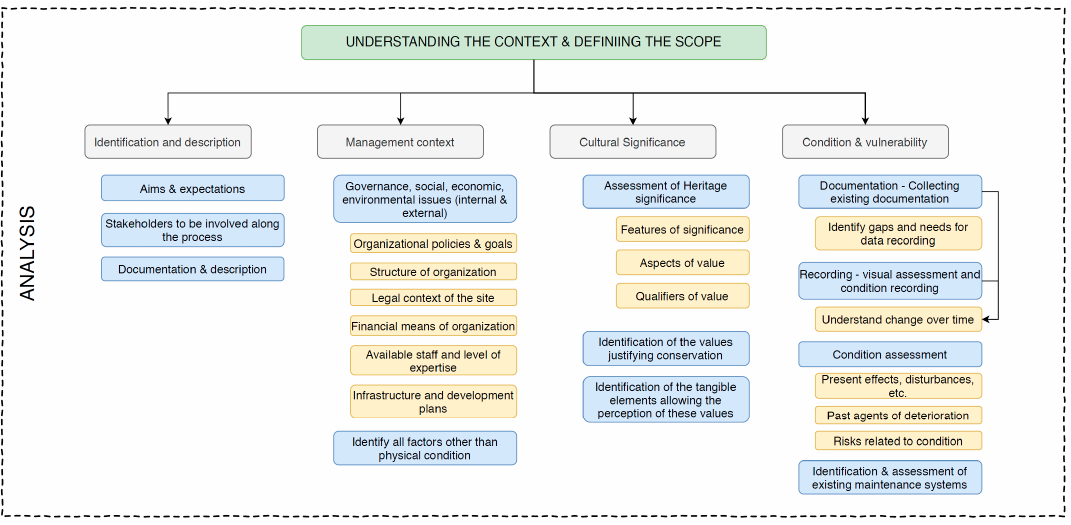
Figure 1. ANALYSIS: the first phase of the management plan process.